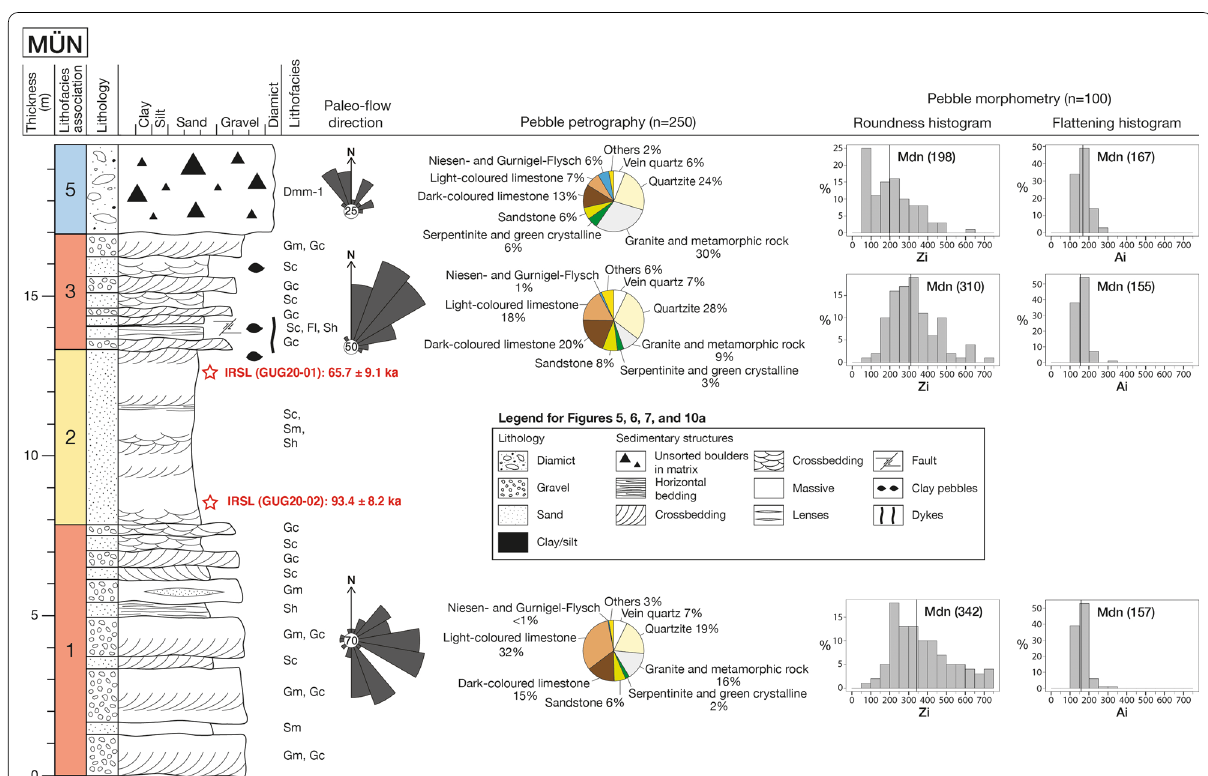
Fig. 5 Sedimentological log of sediments recorded at Müntschemier (MÜN; section situated at CH1903 LFA 5 at 468.6 m a.s.l.) with (i) lithofacies associations (LFA; Table 2), lithofacies (LF; Table 1), projected IRSL (red star: GUG-20–01 and GUG20-02), (ii) paleo-flow directions, (iii) pebble petrography, and (iv) pebble morphometry. See Fig. 2 for location of the